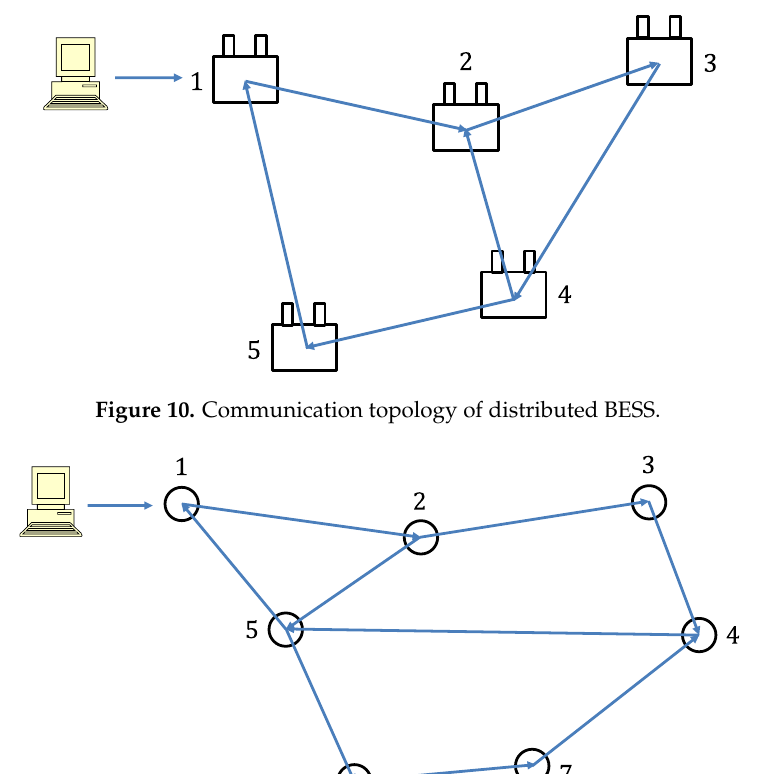
Figure 9. Communication topology of renewable generation.